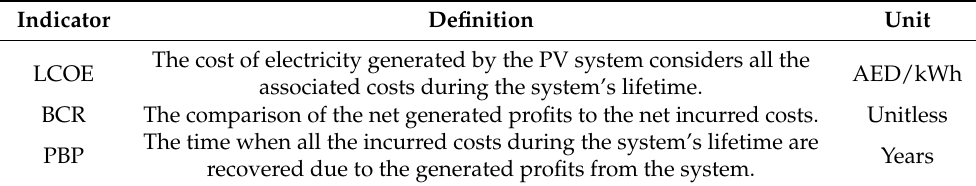
Table 2. List of the considered economic indicators in the